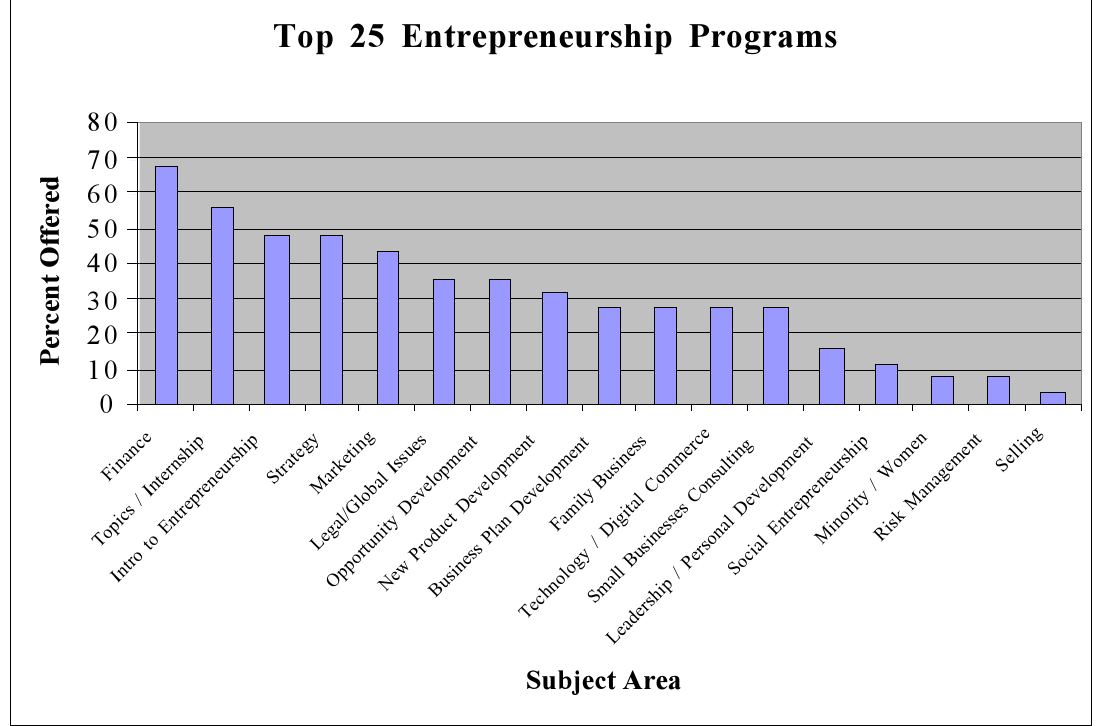
Figure 2. Course Types at 2008 List of Top 25 Undergraduate Schools of Entrepreneurship Source: Entrepreneur.com